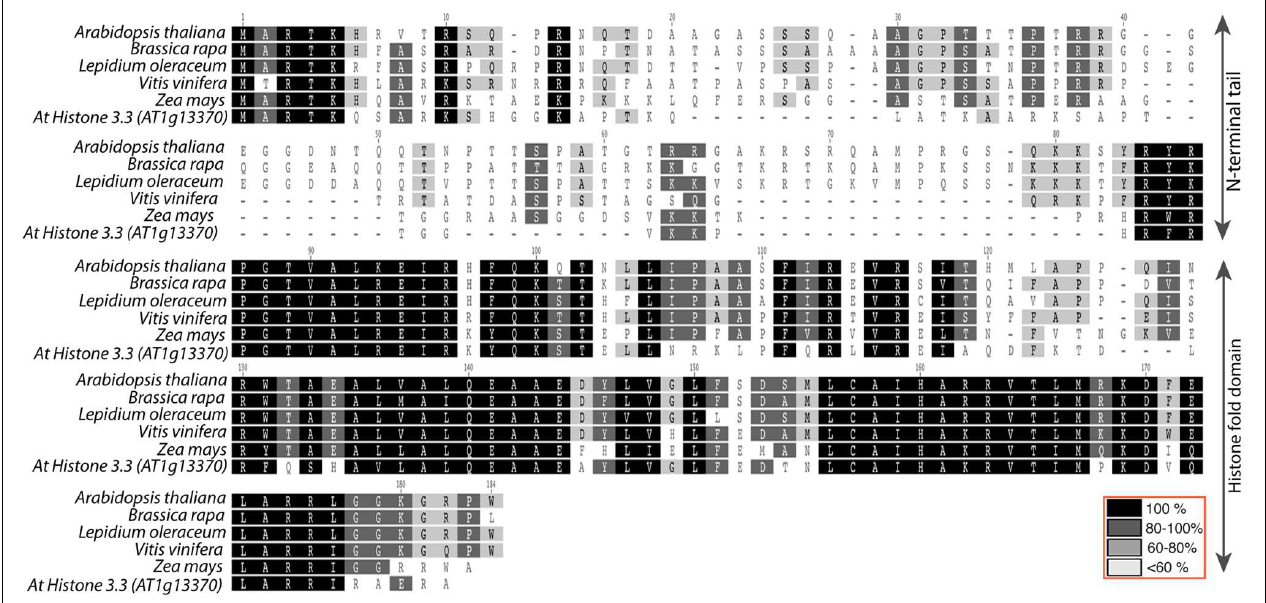
FIGURE 2 | Alignment of Arabidopsis thaliana histone3.3 vs. CENH3 sequences from A. thaliana, Brassica rapa, Lepidium oleraceum, Vitis vinifera, and Zea mays. Top two rows represent N-terminal tail with less conservation and the bottom three columns represent relatively well-conserved histone fold domain.